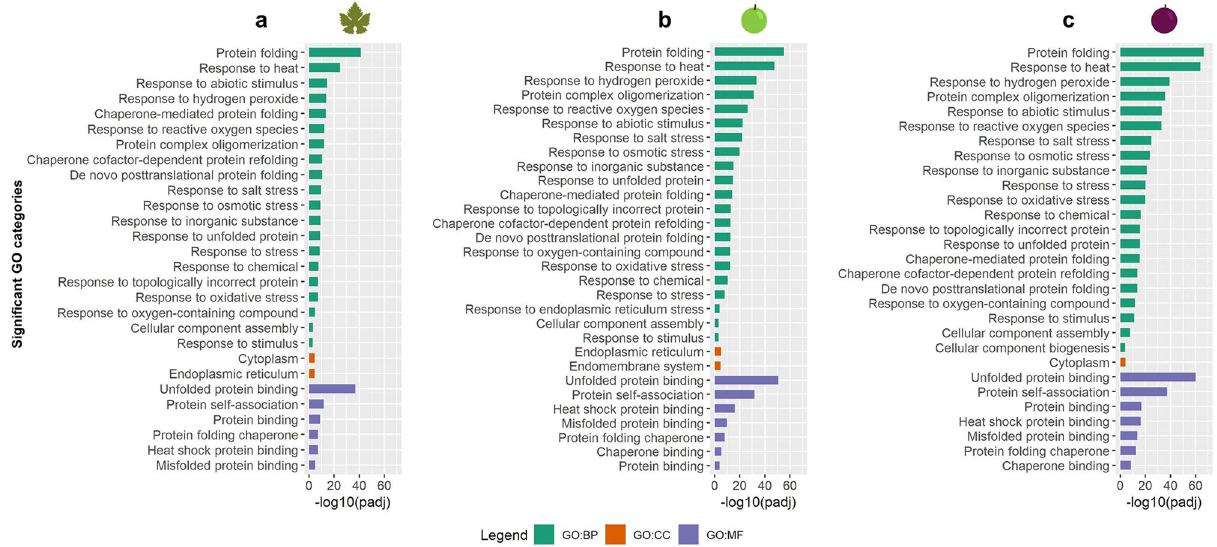
Figure 3. Significantly enriched GO categories in the up-regulated genes in ( a ) leaves, ( b ) berries at the beginning of ripening and ( c ) berries in mid-ripening, divided in biological process (BP, green), cellular component (CC, orange), and molecular function (MF, purple) expressed as − log 10 (adjusted p